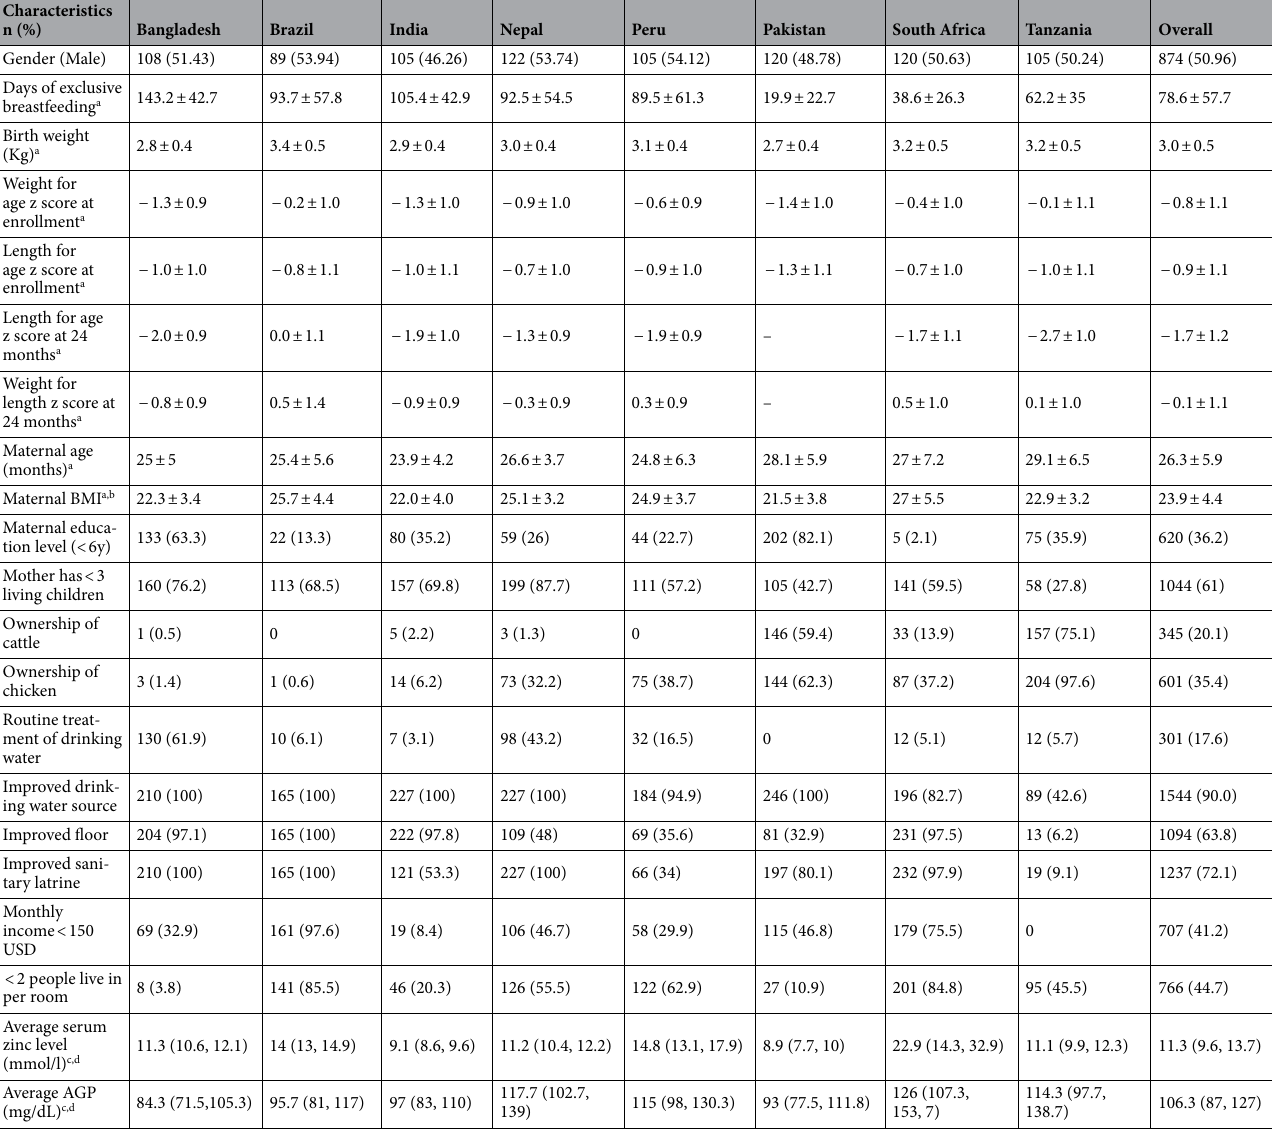
Table 1. General characteristics of the MAL-ED study Children (n = 1715) from Bangladesh, India, Nepal, Pakistan, South Africa, Tanzania, Brazil, and Peru from November 2009 to February 2012. a Mean ±